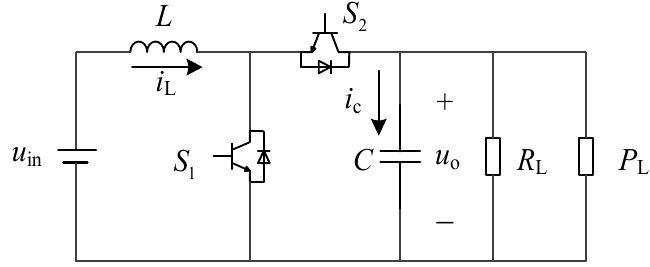
Figure 2. Model of bidirectional DC/DC converter.